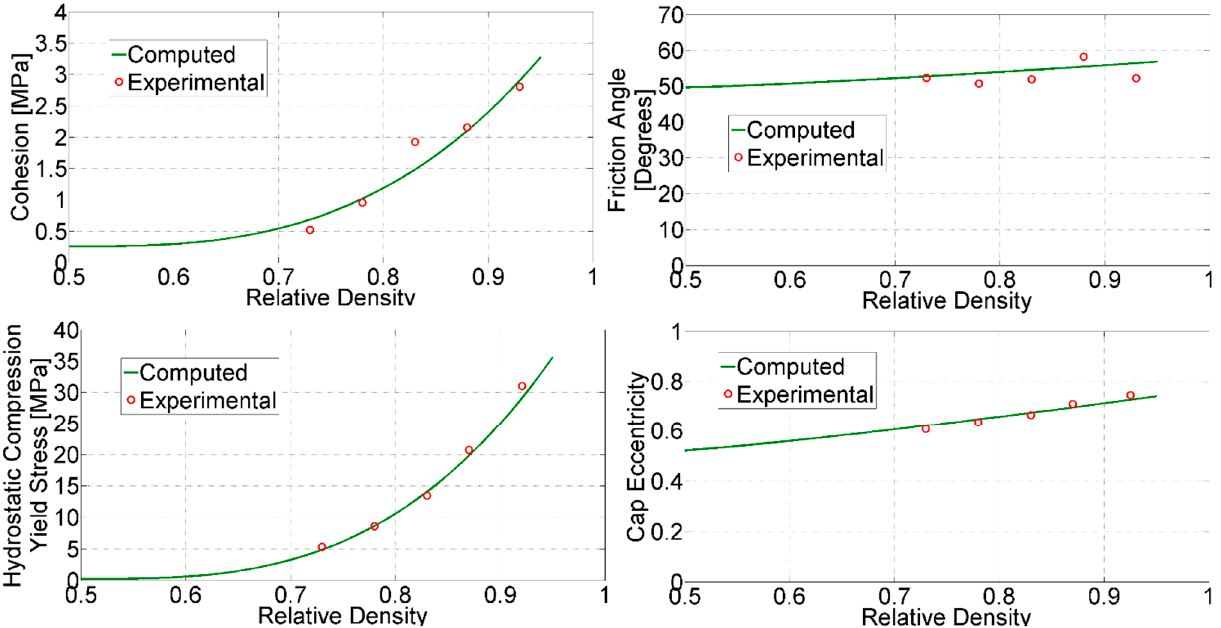
Figure 13. Comparison of assessed parameter values (continuous curve) against their values assessed through destructive tests (circles).